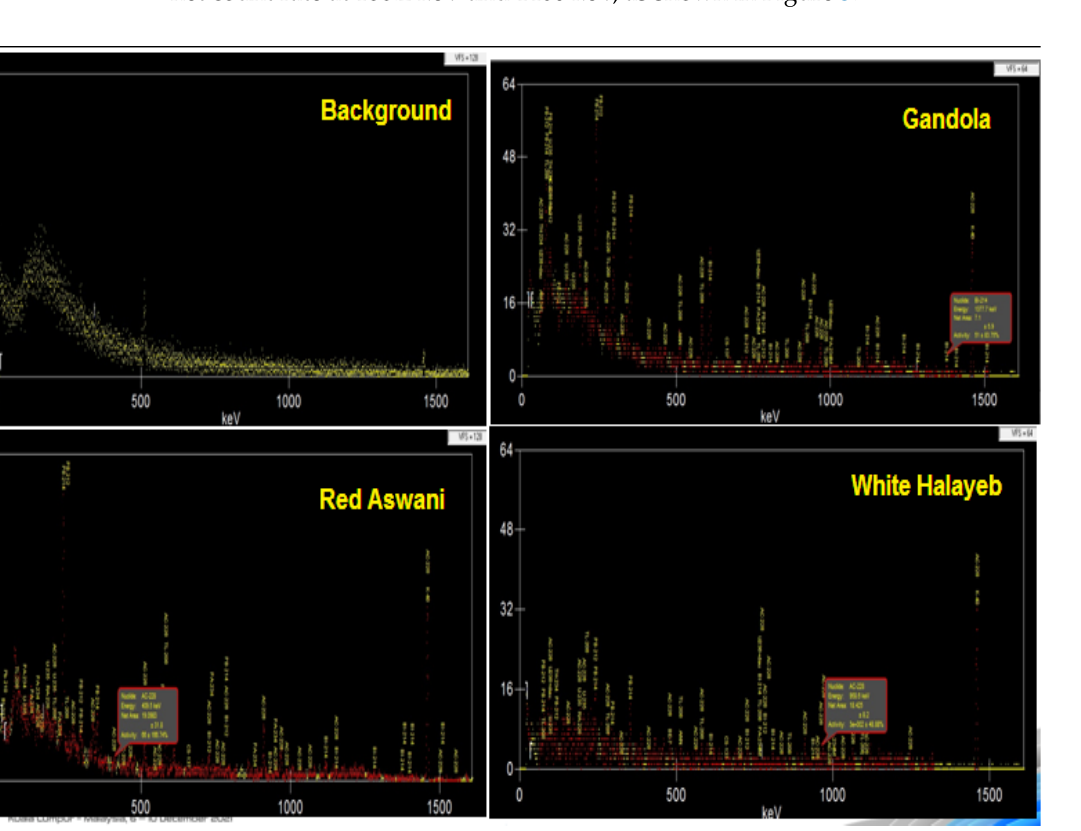
Figure 3. Experimental spectrums using the HPGe detector for background radiation and the three discussed granite samples.